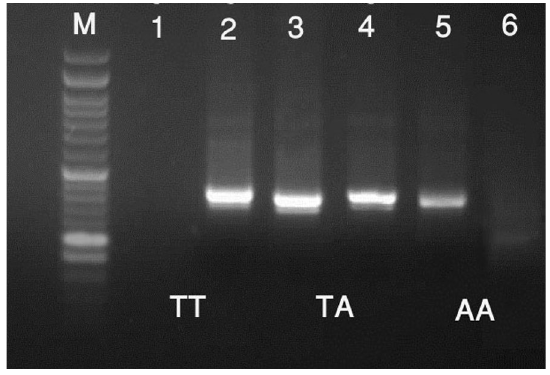
Fig. 1 Agarose gel electrophoresis for detection of rs5902434 polymorphism. Lane (M): molecular weight marker, lanes 1,2 TT genotype; lanes 3, 4: TA genotype and lanes 5,6: AA